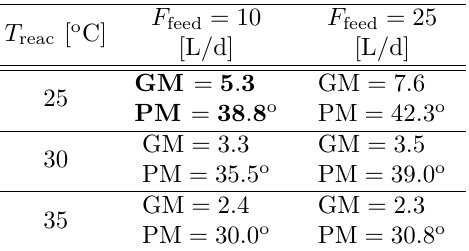
Table 3: Stability margins of the methane control sys- tem at various operating points. The upper left cell is the basic operating